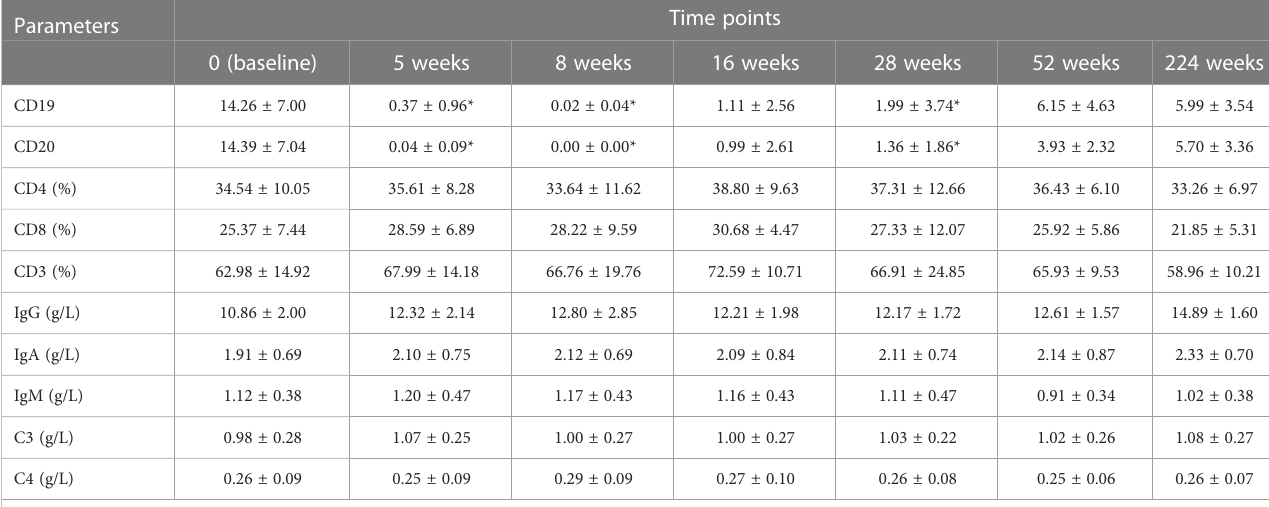
TABLE 2 Changes of B and T cell subsets and immunoglobulins in TAO patients after rituximab treatment during the follow-up period.